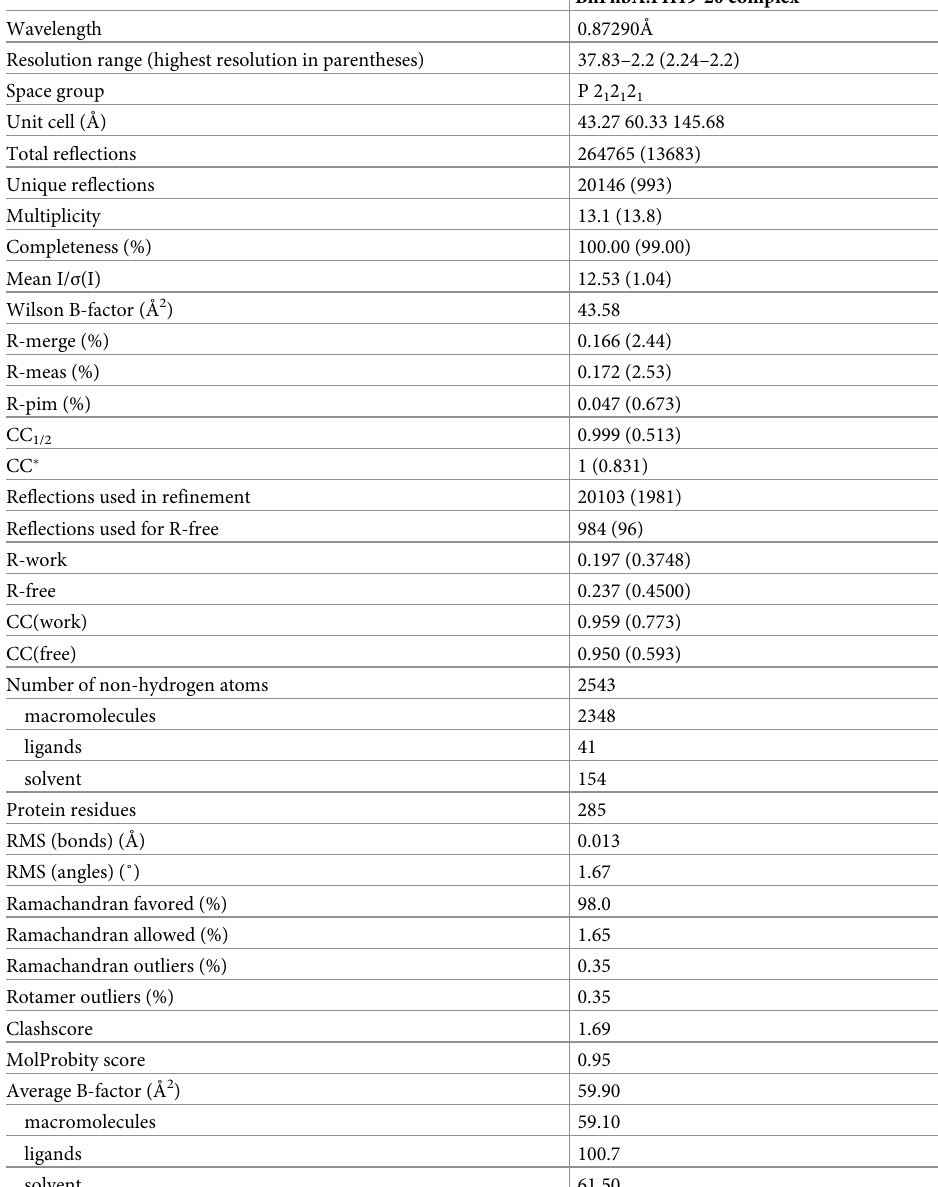
Table 1. Crystallographic data and model